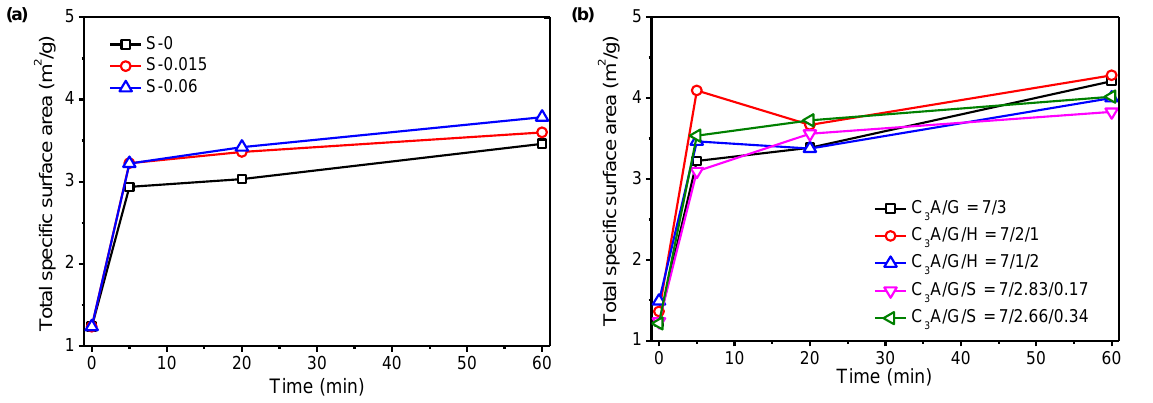
Figure 4. Specific surface area along C 3 A hydration: ( a ) effect of SO 4 2− concentration in simulated solution; ( b ) effect of hemihydrate and Na 2 SO 4 in solid.